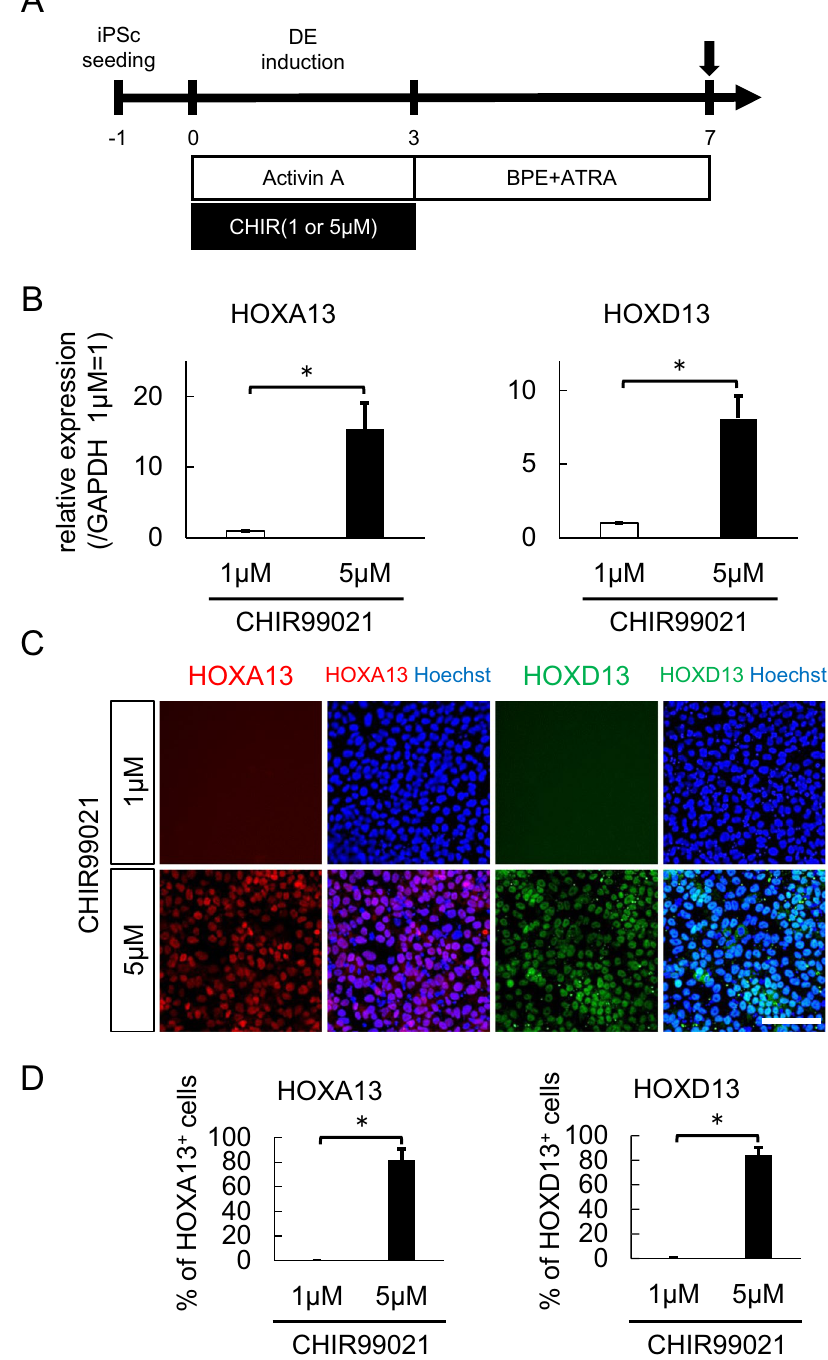
Figure 2. Treatment with a high-dose GSK3 β inhibitor efficiently induced caudal hindgut. ( A ) A schematic diagram of hindgut maturation after posterior DE induction. ( B ) An expression analysis of the hindgut markers HOXA13 and HOXD13 after four days of maturation following posterior DE induction with the indicated dose CHIR by qPCR (n = 3 independent experiments; mean ± SEM). ( C ) Immunostaining of HOXA13 and HOXD13 in differentiated cells. Representative fluorescence microscopic images for treatment with 1 µ M (upper panels) and 5 µ M CHIR (lower panels) are shown. Scale bar, 100 µ m. ( D ) The proportions of HOXA13 (left panel)- and HOXD13 (right panel)-positive cells (n = 3 independent experiments; mean ± SD). * p < 0.05; two-tailed paired t -test. Abbreviations: iPSc, induced pluripotent stem cell; DE, definitive endoderm; CHIR, CHIR99021; BPE, bovine pituitary extract; ATRA, all-trans retinoic